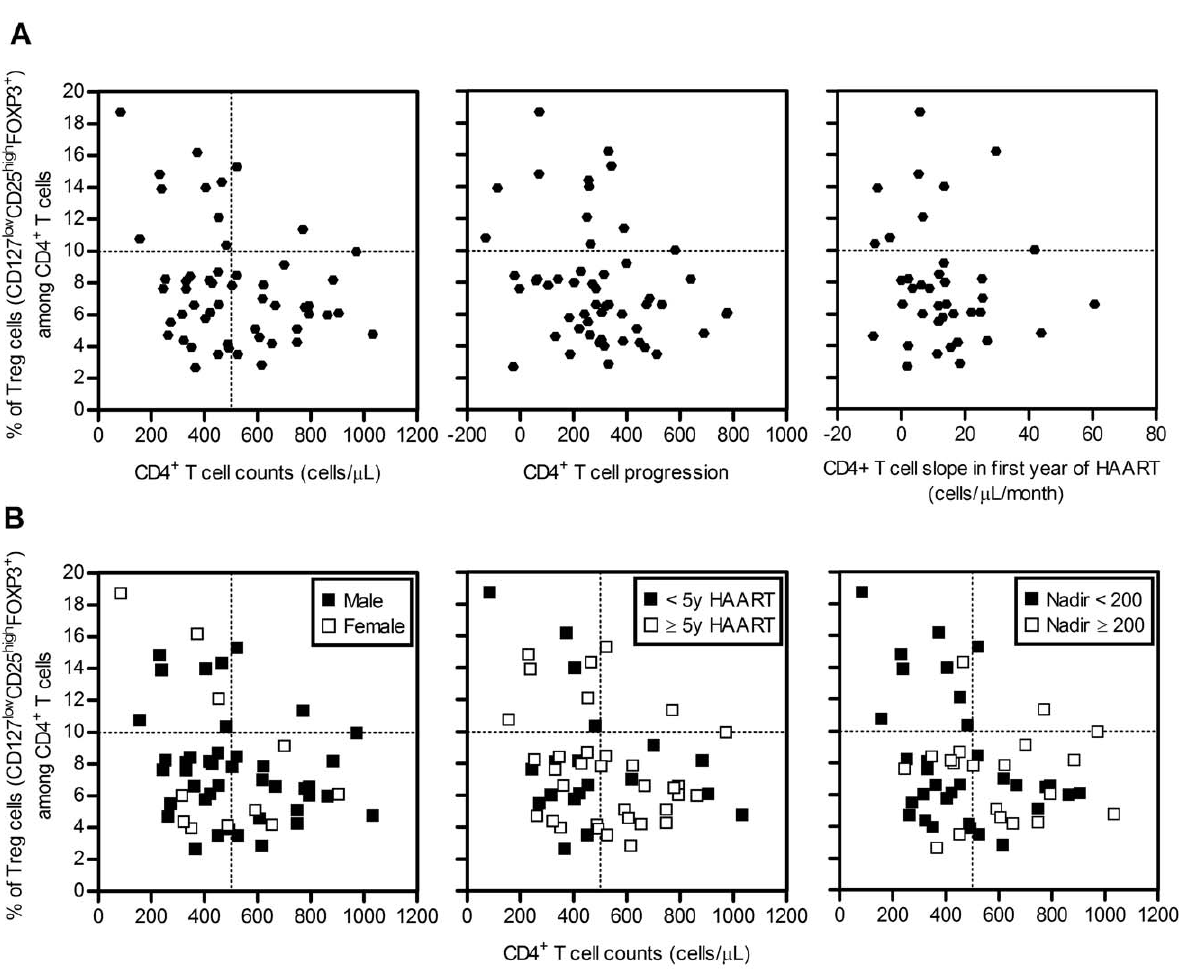
Figure 2. HIV + individuals with high Tregs percentages feature low CD4 + T cell counts and Nadir values. A. Percentages of Tregs amongst HIV + individuals were plotted against CD4 + T cell counts, CD4 + T cell progression and CD4 + T cell slope (for the first year of HAART). Each dot represents a single individual. B. Tregs percentages were plotted against CD4 + T cell counts in HIV + individuals grouped by gender) number of years under HAART and the Nadir value.